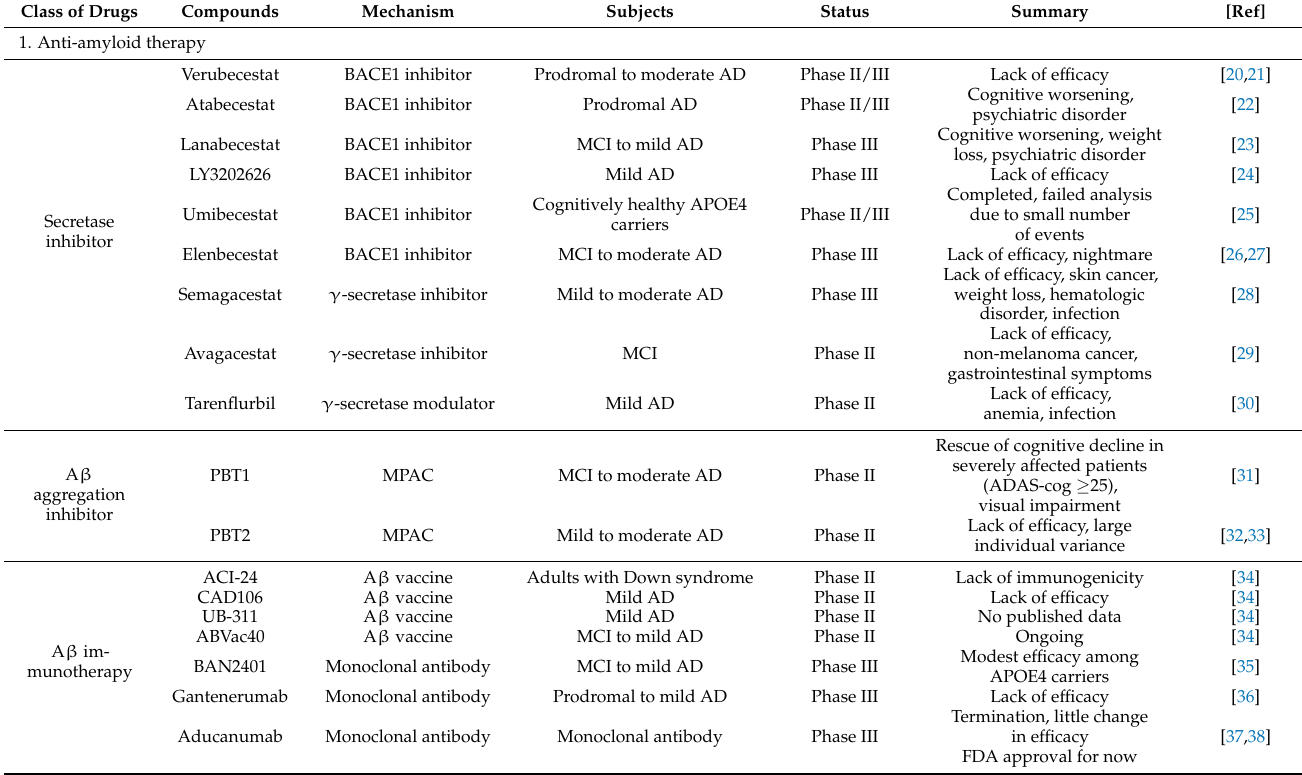
Table 1. Summary of pharmacological interventions against